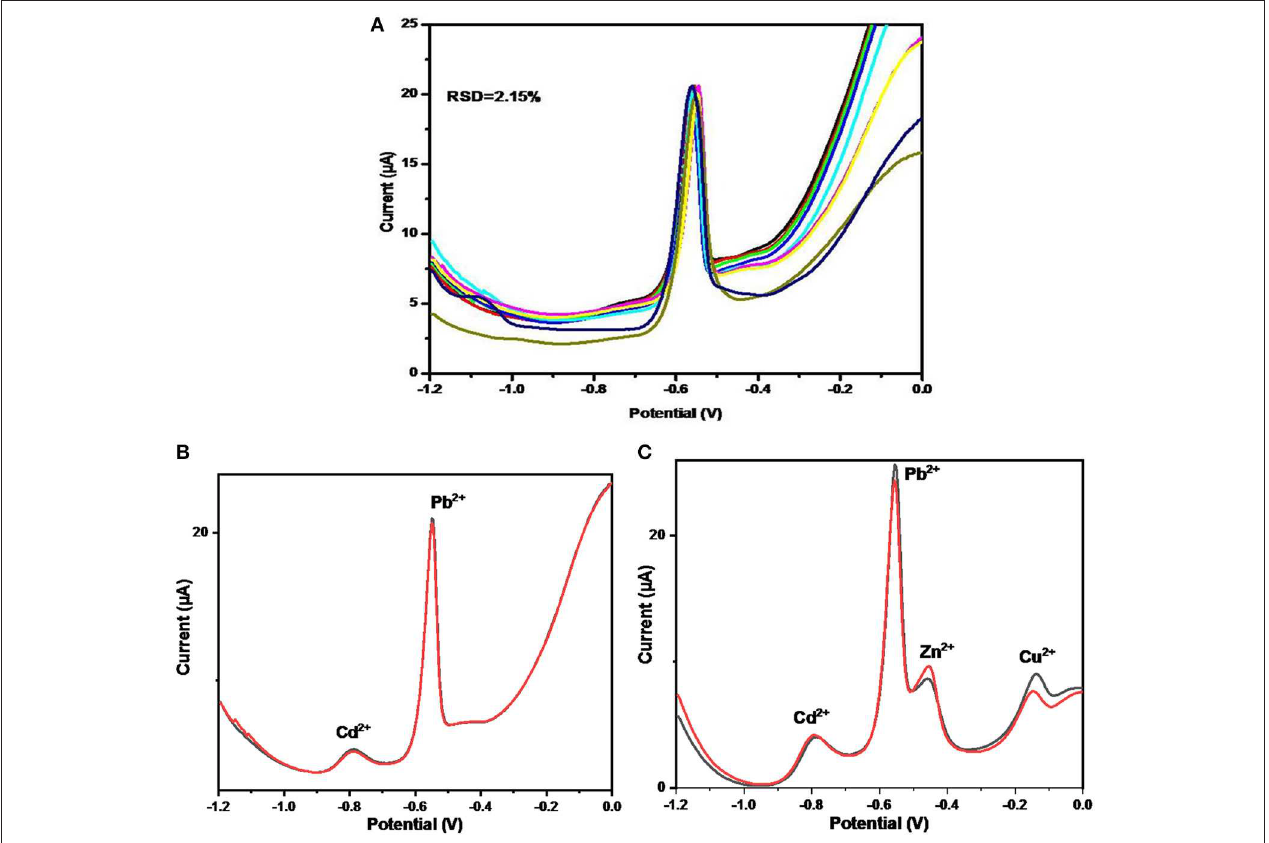
FIGURE 11 | The DPASV stripping signals on ErGO–MWNTs–L-cys modified GCEs for: (A) 9 times measurements with four identical modified GCEs toward 40 µ gL − 1 of Pb 2 + ions (B) , 50 µ gL − 1 of (Pb 2 + , Cd 2 + , Na + , K + , Mg 2 + , Fe 3 + , Co 2 + , Ca 2 + , & NO3 2 − ) ions, and (C) 50 µ gL − 1 of (Pb 2 + , Cd 2 + , Na + , K + , Mg 2 + , Fe 3 + , Co 2 + , Ca 2 + , & NO 2 − 3 ) ions in acetate buffer solution under optimal